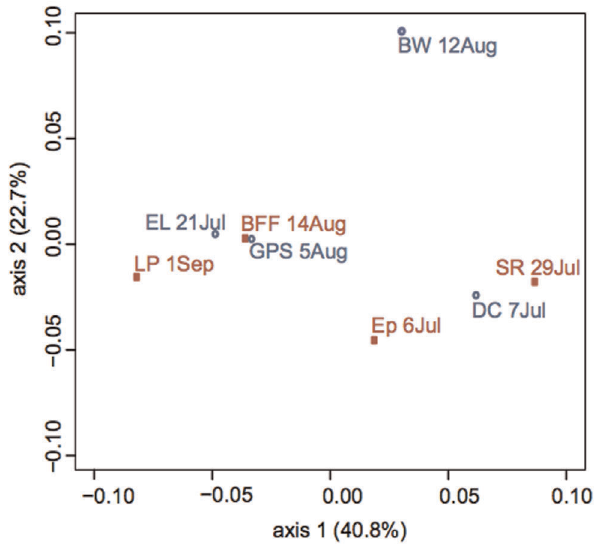
Figure 2. PCoA plot of weighted Unifrac generated from a maximum likelihood tree. Red squares indicate orchards that were sprayed with streptomycin; blue circles indicate orchards that were not